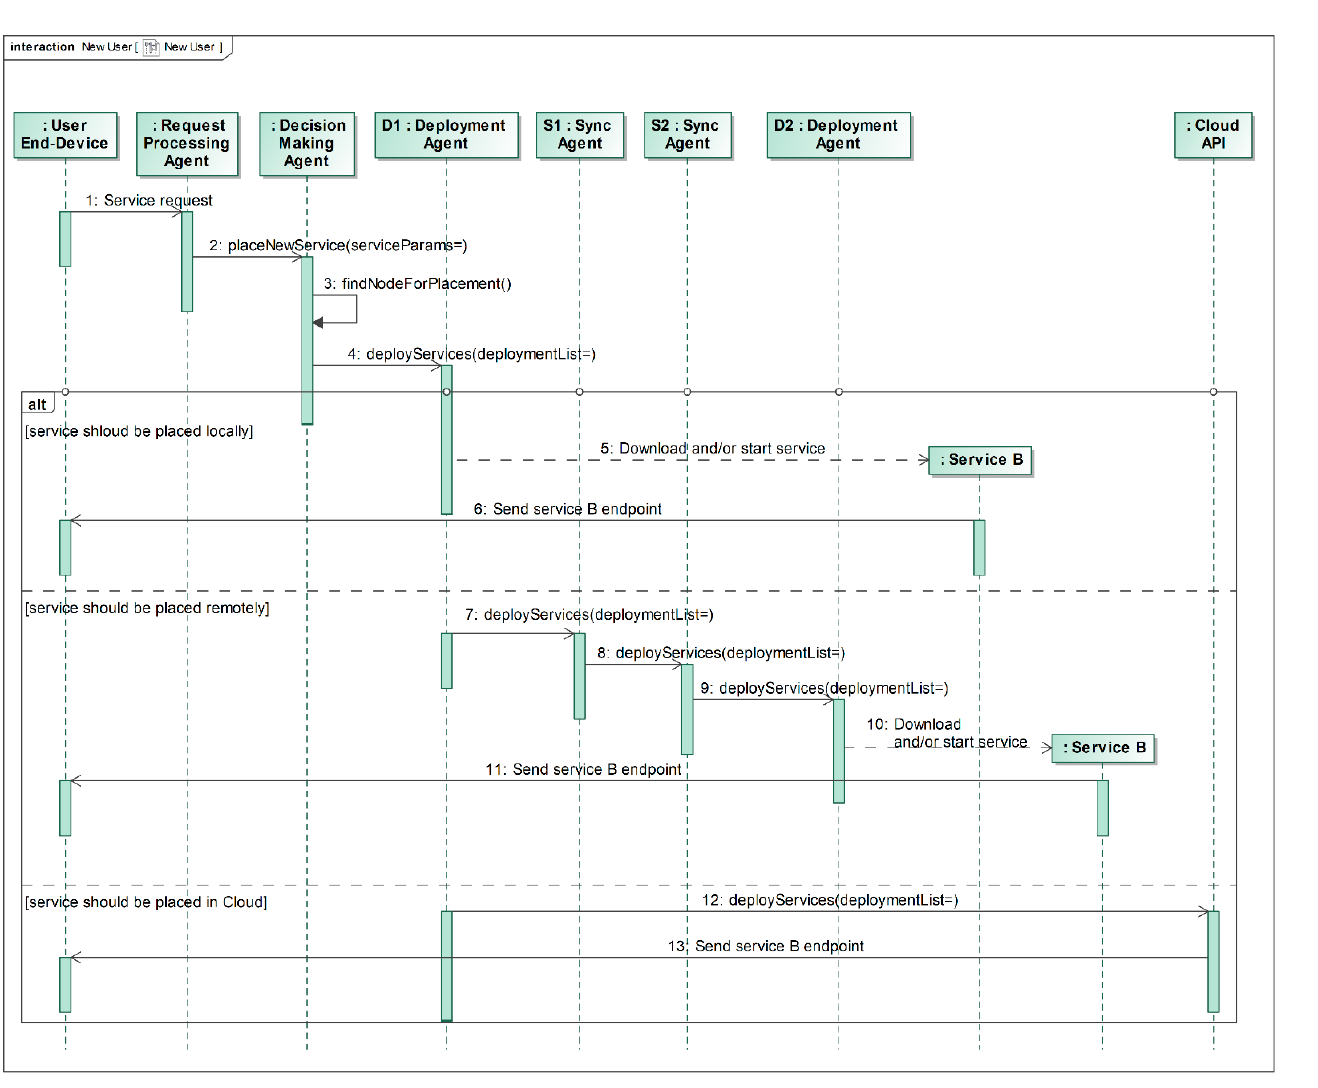
Figure 5 . New service deployment, depending on the destination fog node given by the best placement algorithm.